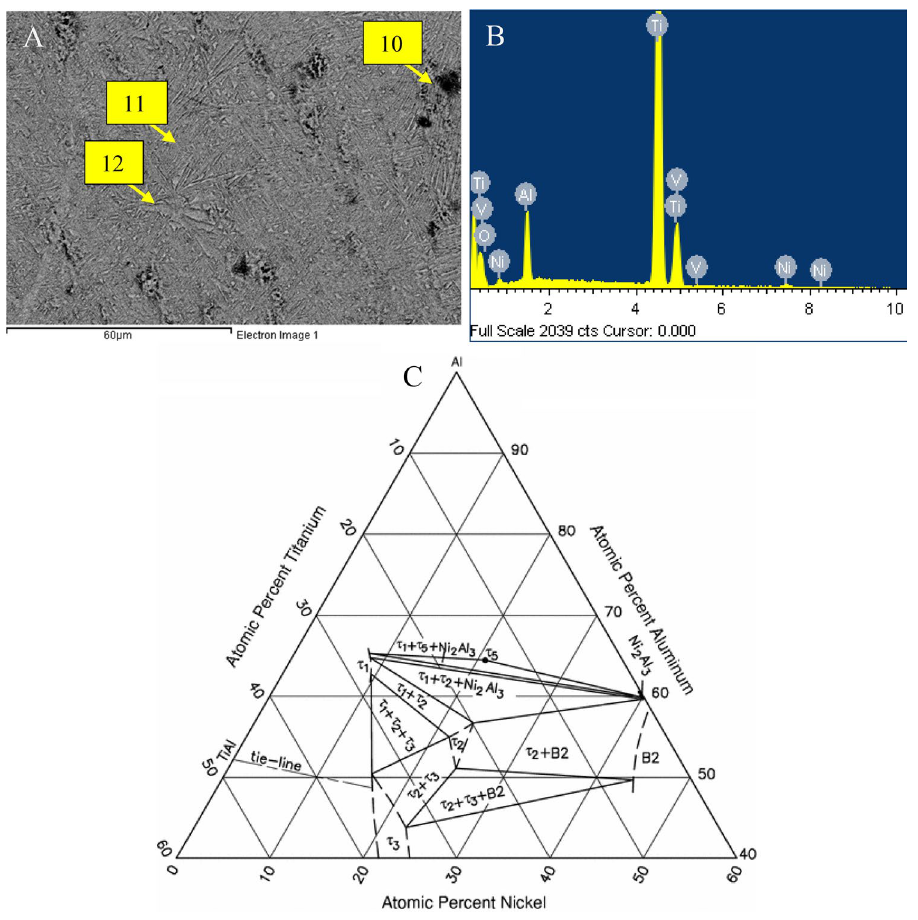
Figure 6. ( A ) SEM micrograph of the sample Ni coating containing 30 nm TiO 2 /40 nm Al 2 O 3 ( B ) EDS spectrum of the treated layer showing the Ni content from the coating ( C ) Ti–Ni–Al phase diagram (V.